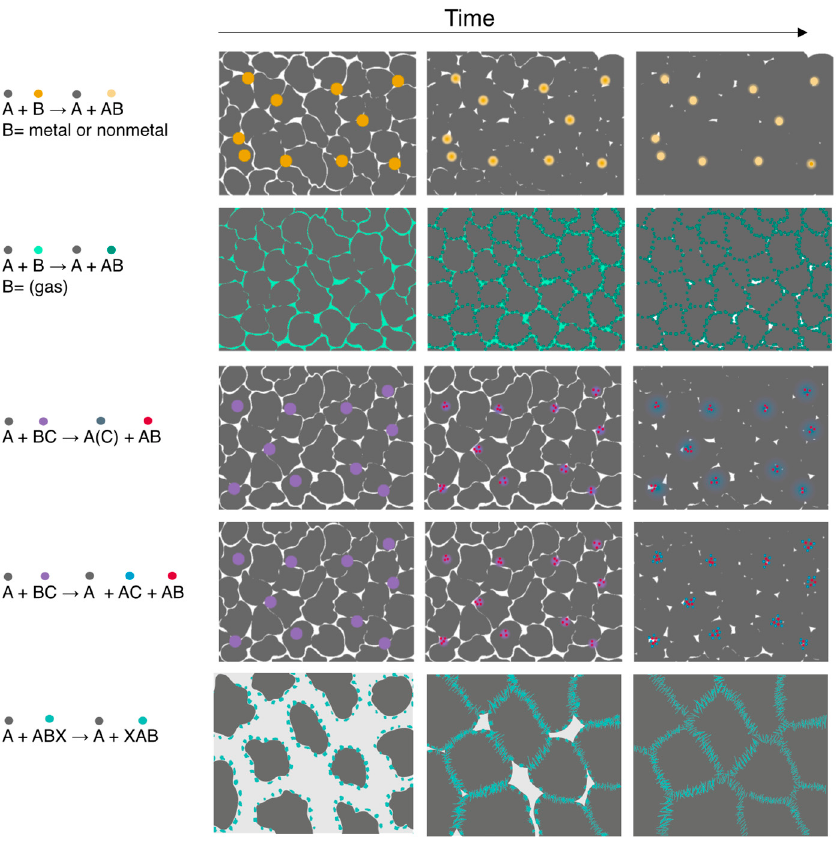
Figure 6. Microstructural evolution of raw material possibilities for type A + AB composites The pictures in the first column correspond to the beginning of the reaction (t = 0), the second column to an intermediate state of the process, and the third column to the system’s final state. Table 1. Raw material possibilities for composites of type A + AB. Δ G is the Gibbs free energy change of the reaction, G is the Gibbs free energy of element i, and p B is the partial pressure of B in atm. R and P subscripts in the fourth column stand for reactant and product amounts of A, respectively. For the sake of simplicity, there is no mass balance in the reaction equations. Figures in the “examples” column are meant to illustrate microstructural features listed in the summary.